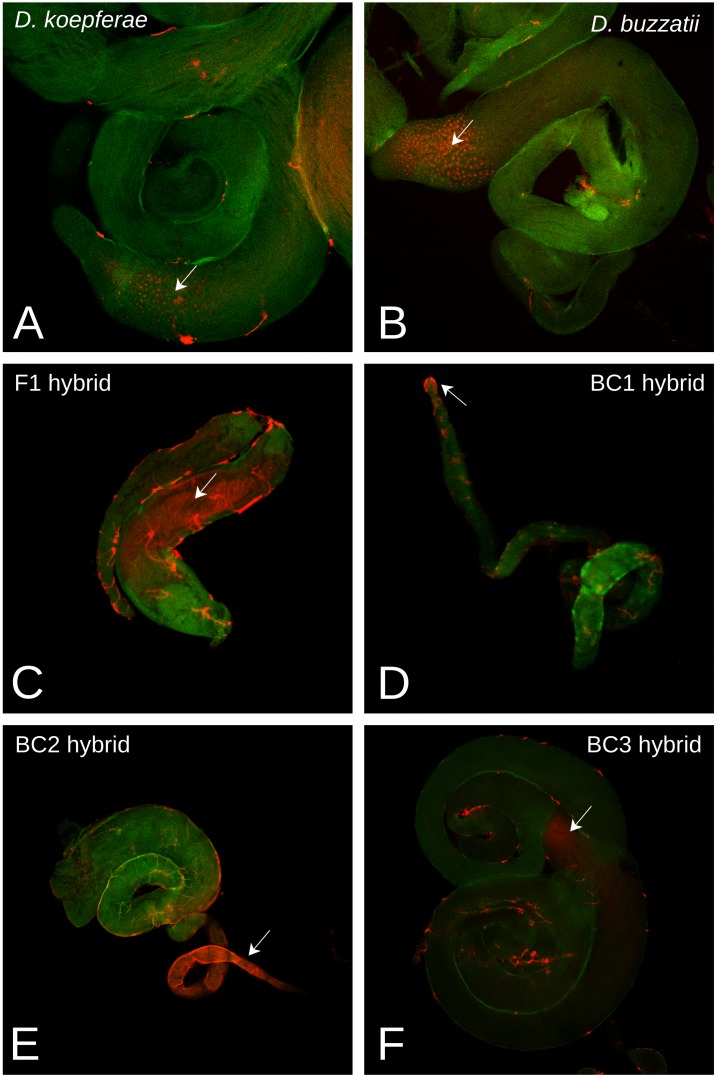
FISH of Helena RNA expression in testes.Red staining are Helena transcripts, green staining is tissue autofluorescence. Arrows mark the presence of Helena transcripts. A)
D. koepferae, B)
D. buzzatii, C) F1 hybrid, D) BC1 hybrid, E) BC2 hybrid, F) BC3 hybrid.